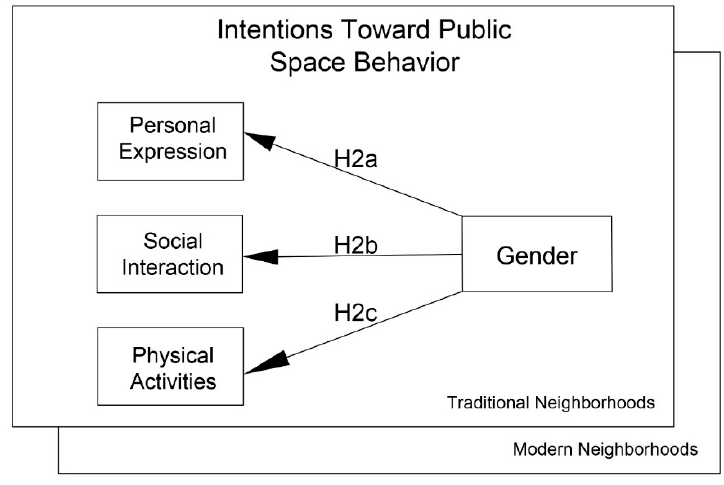
Figure 5. Model 2 for the second three hypotheses.